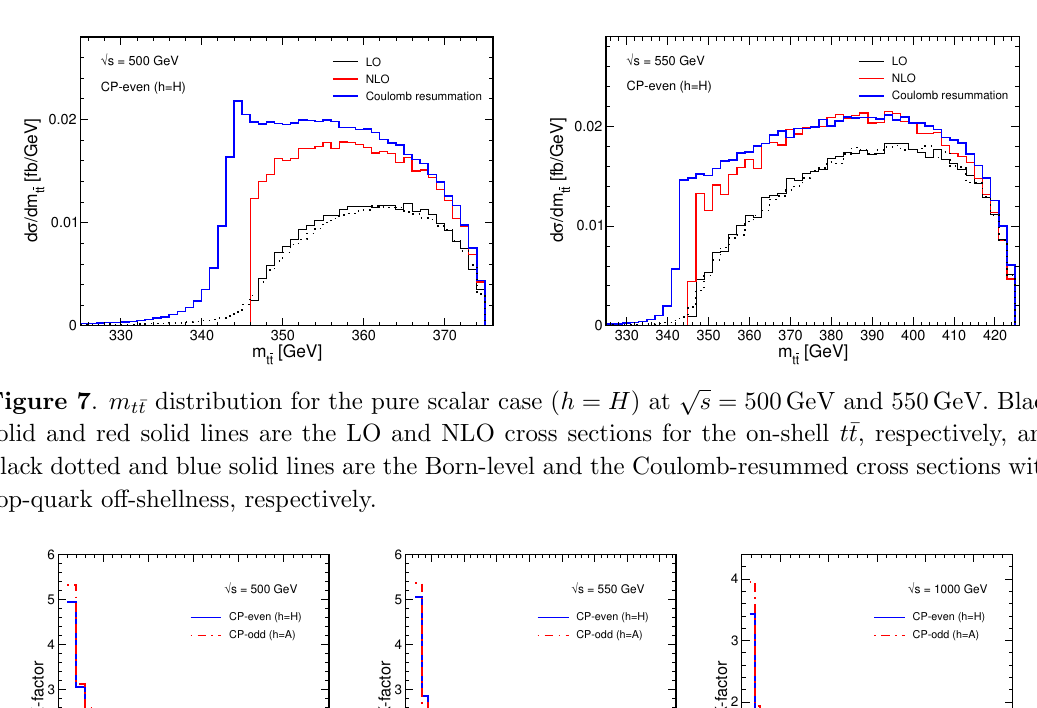
Figure 8 . m t (cid:22) t dependence of the NLO QCD K -factors in the e ( h = H ) and CP-odd ( h = A ) limits at p s = 500 GeV, 550 GeV, and 1000